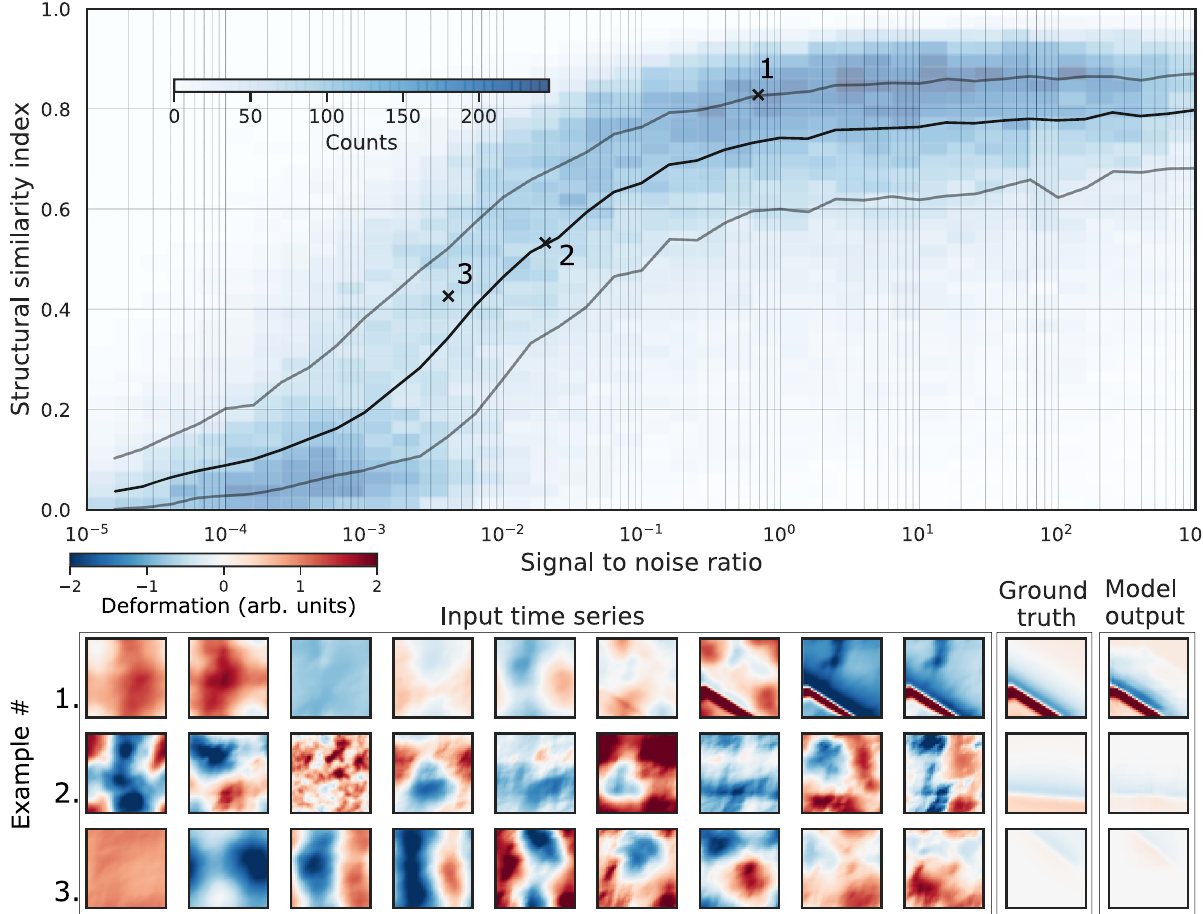
Fig. 2 Performance on synthetic test data. Top: performance of the reconstruction of fault deformation by our deep autoencoder, on synthetic noisy time series, as measured by structural similarity index (SSIM) between model output and deformation ground truth, as a function of signal-to-noise ratio (SNR, see “ Methods ” ). Shades of blue show the distribution of SSIM as a function of SNR (counts per bins for 10 5 test samples). The black and gray lines show the median and 25th and 75th percentile of the SSIM in SNR bins, respectively. Bottom: examples of the data showing input time series, ground truth, and its reconstruction, for different signal-to-noise ratios, shown with matching numbers in the plot above. Note that the model outperforms the eye, recovering with reasonable fi delity deformation signals with SNRs down to a few